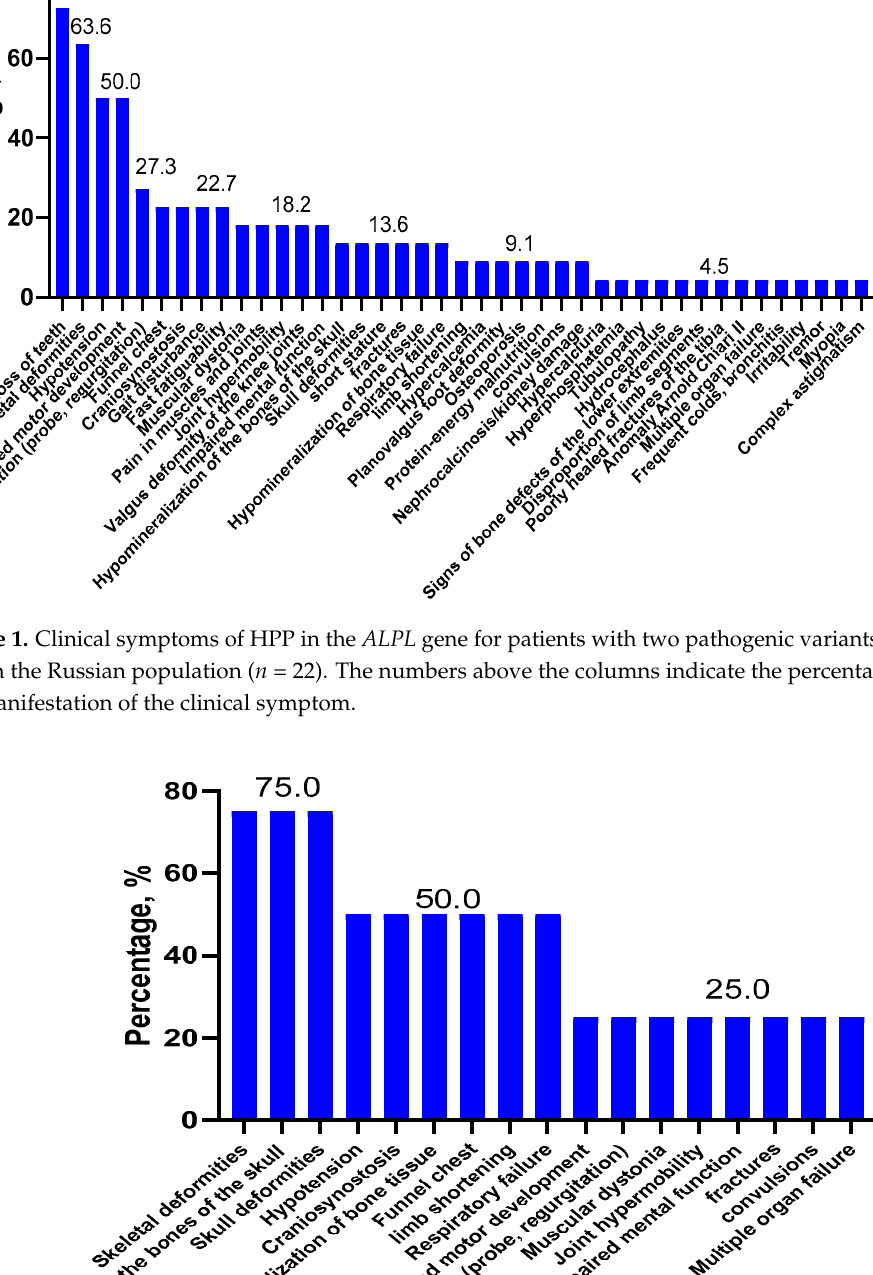
and malnutrition (50.0%) (Figure Figure 2. Clinical symptoms of HPP in children with perinatal HPP ( n = 4).